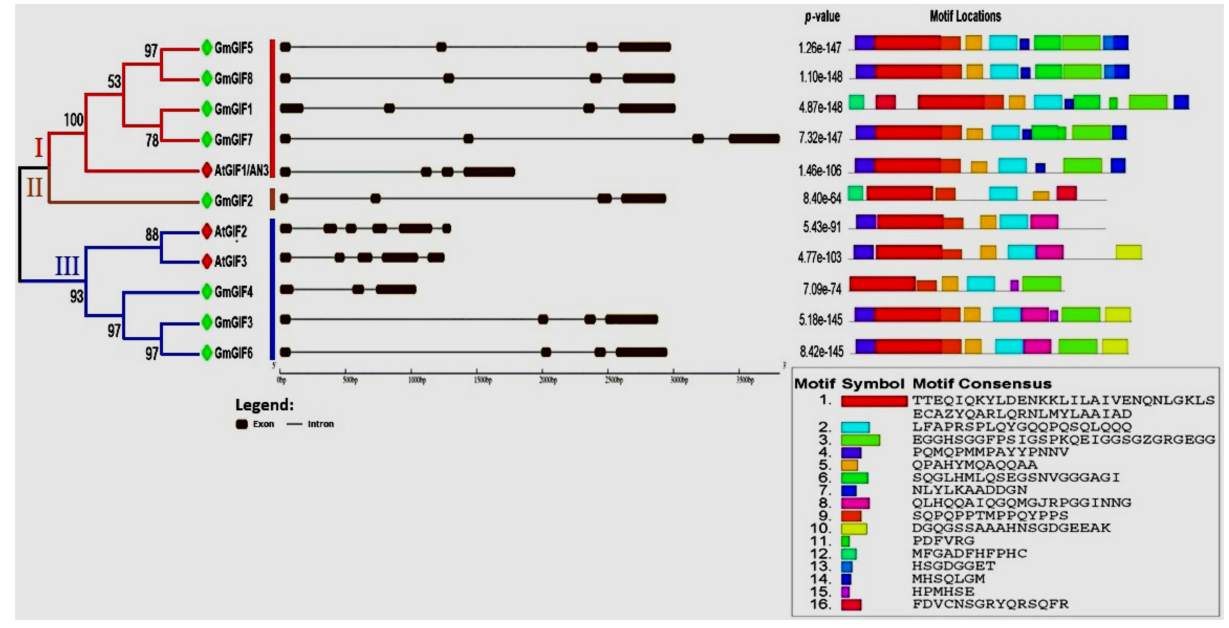
Figure 2. Schematic diagram of A. thaliana and soybean GIF gene organization and conserved motifs analysis. On the left side, the neighbor-joining (NJ) phylogenetic tree is shown, followed by the exons–introns, which are shown as black boxes and grey lines, respectively. On the right side of the picture, the neighbor-joining (NJ) phylogenetic tree is shown, followed by the various motifs depicted in various colors. Nonconserved sequences are indicated by black